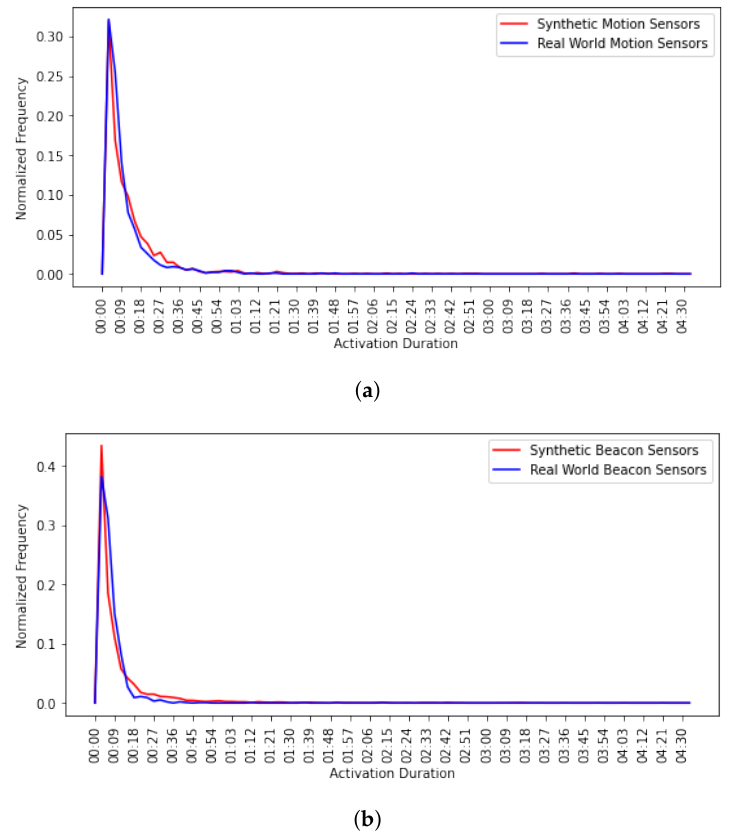
Figure 10. Normalized frequency of activation duration for ( a ) synthetic and real-world motion sensors, and ( b ) synthetic and real-world beacon sensors.